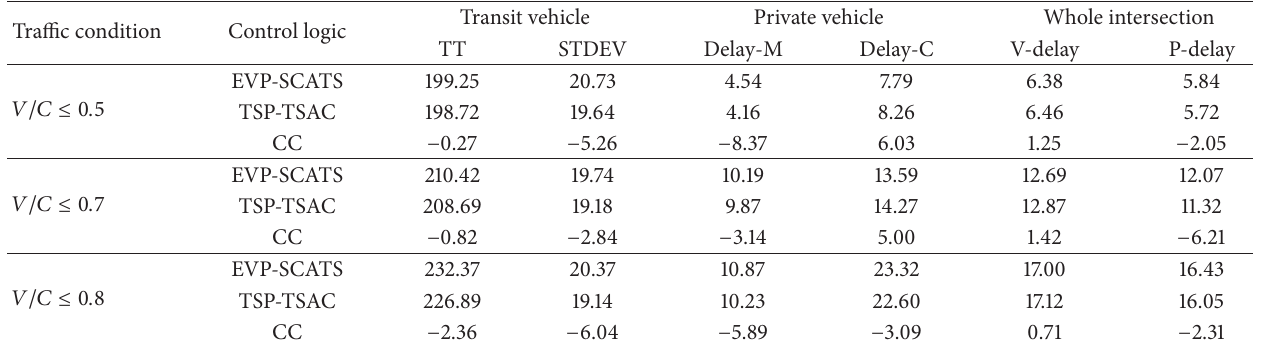
Table 1: The performance indices of transit vehicle and private vehicle at 𝑉/𝐶 ≤ 0.8 . Traffic condition